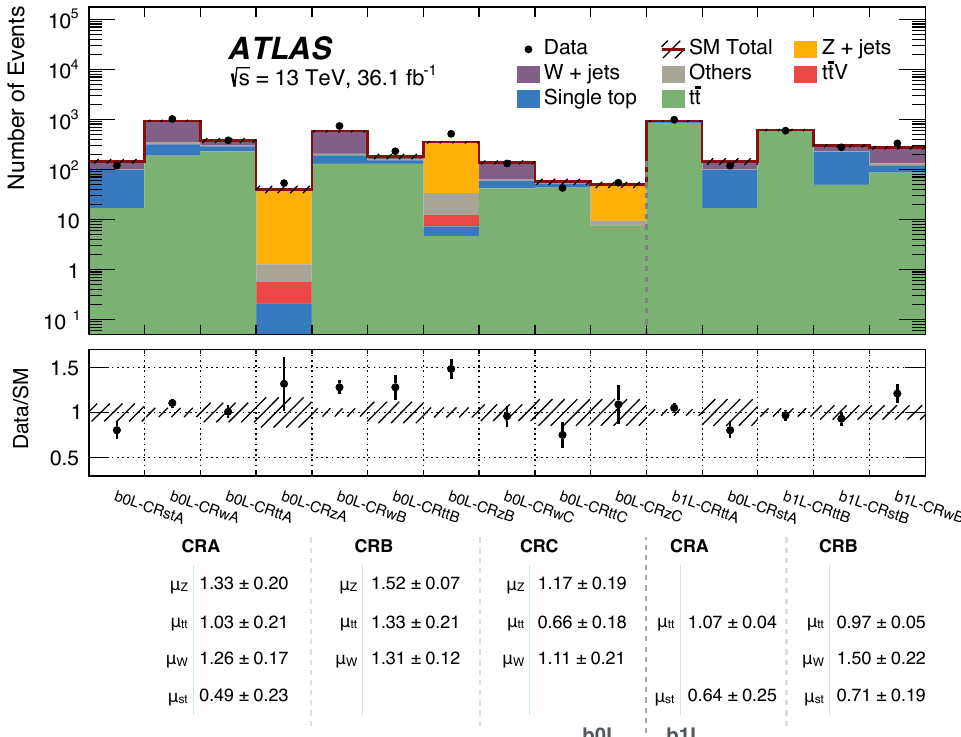
Figure 3. Data and MC predictions for all CRs associated with all b0L and b1L SRs before the likelihood (cid:12)t, as well as the results obtained by the likelihood (cid:12)t. In the top panel the normal- ization of the backgrounds is obtained from MC simulation and is the input value to the (cid:12)t. The contributions from diboson, multijet and rare backgrounds are collectively called \Others". The panels at the bottom show the ratio of the observed events in each CR to the MC estimate, and the value of the normalization factors ( (cid:22) ) obtained for each of the backgrounds (cid:12)tted. The uncertainty band around the MC prediction includes only the statistical uncertainty of the MC samples. The normalization factors (cid:22) are presented for each region and SM background process and take into account statistical and detector-related systematic uncertainties.